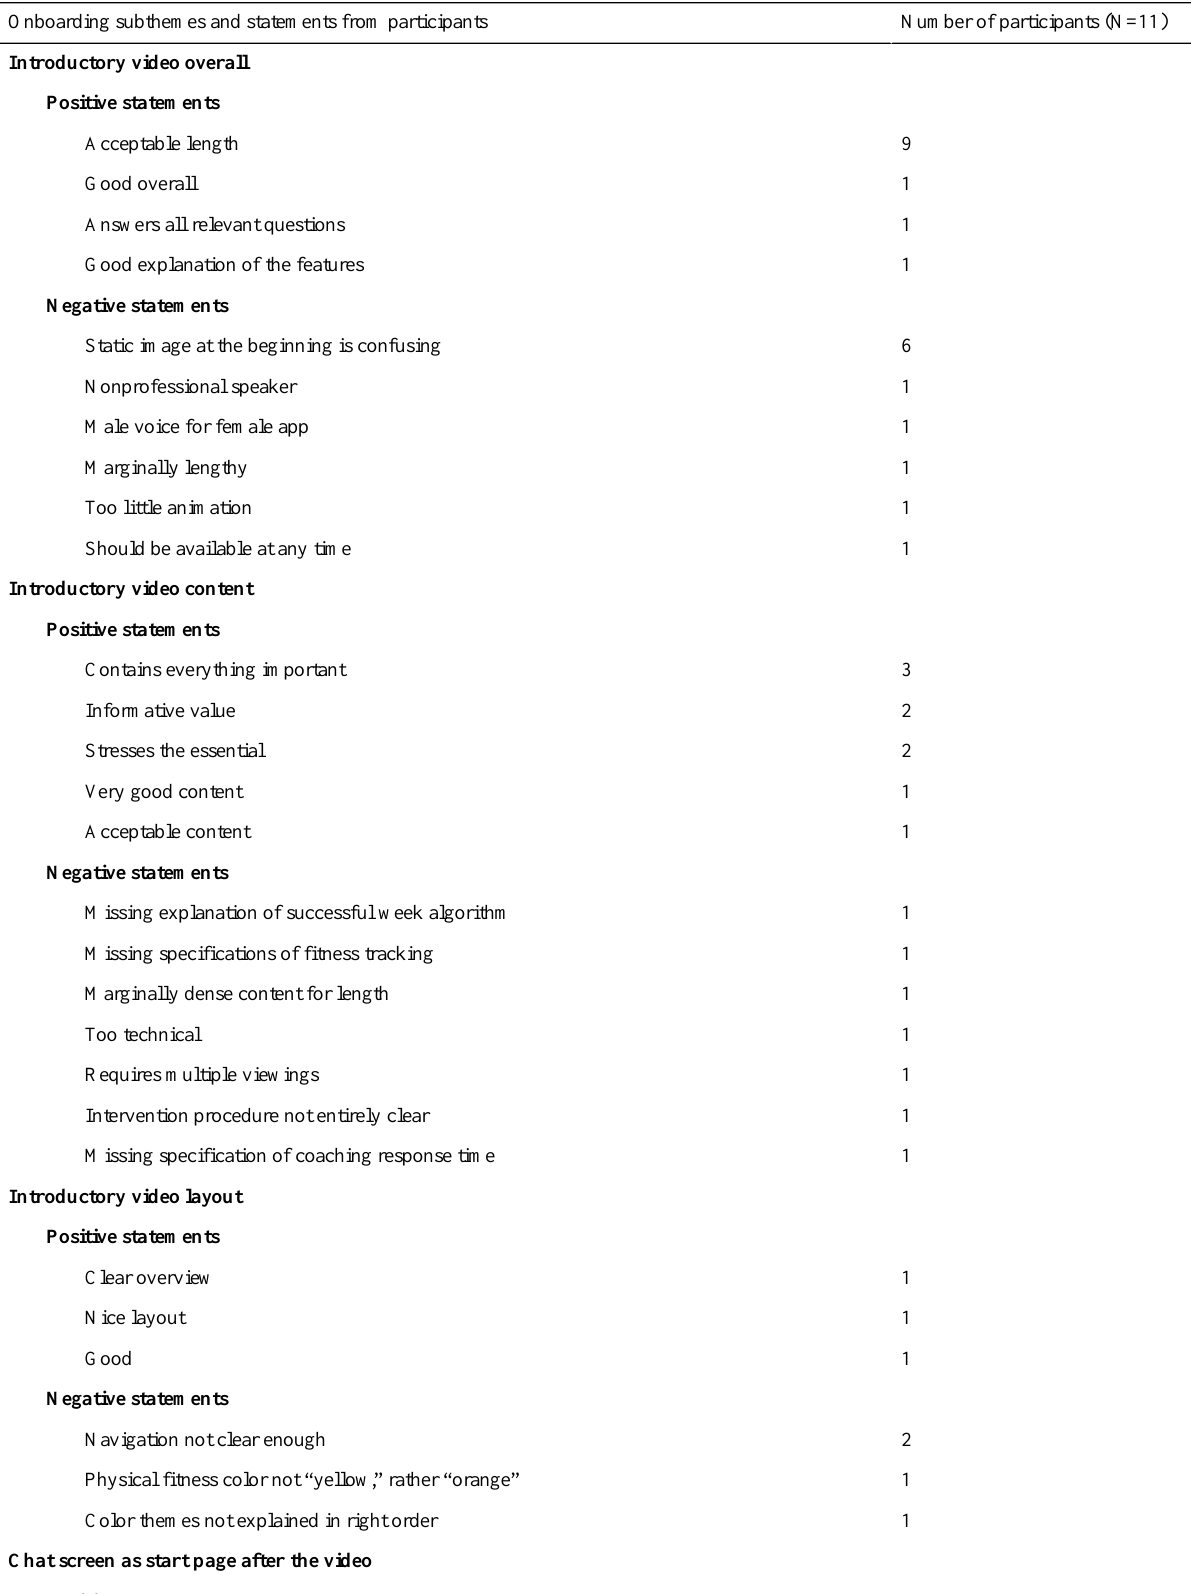
Table 4. Exemplary analysis of the think-alouds with semistructured interviews for the onboarding process in the TRIANGLE user